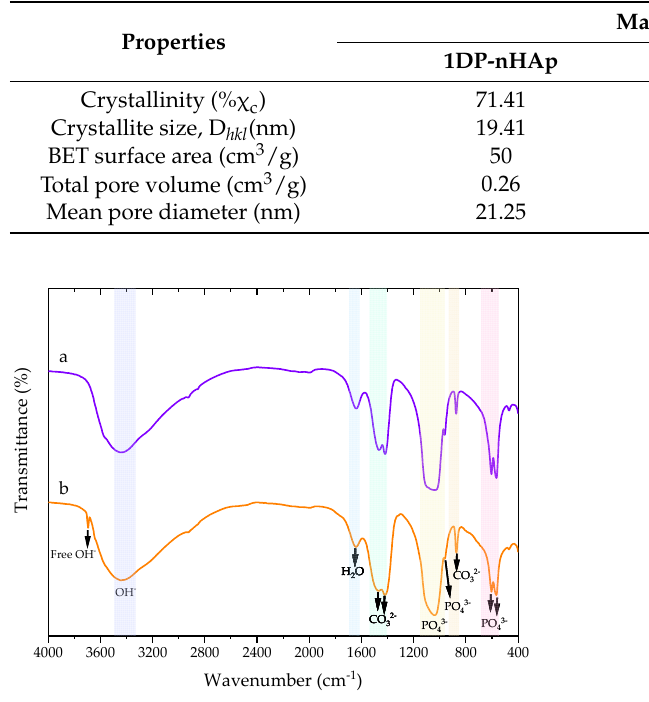
Figure 3. FT-IR transmittance spectra of nHAp powder (a) 1DP-nHAp and (b) Figure 3. FT − IR transmittance spectra of nHAp powder (a) 1DP − nHAp and (b) 2DP − nHAp.